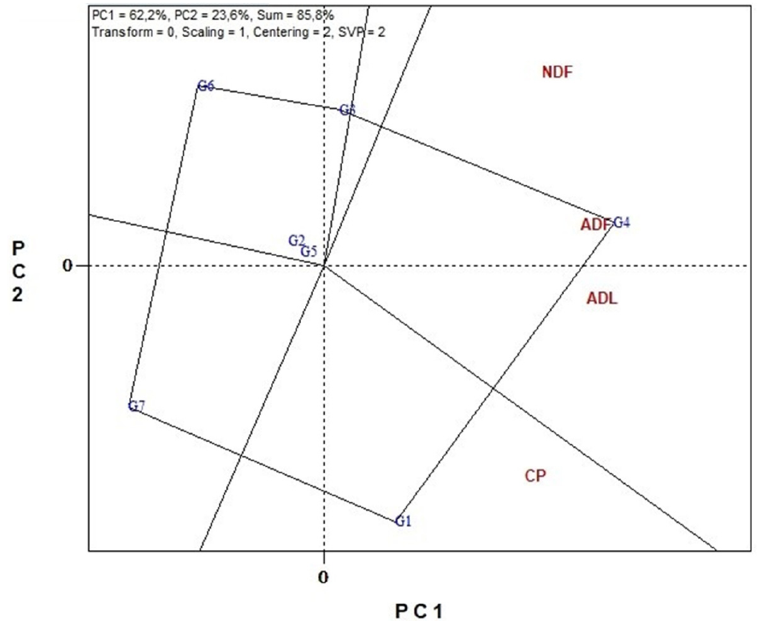
Figure 5. “Which-won-where or which is best for what” view of the GGE biplot for genotypes by nutritional traits representing seven V. sativa genotypes measured for four traits averaged across six environments.